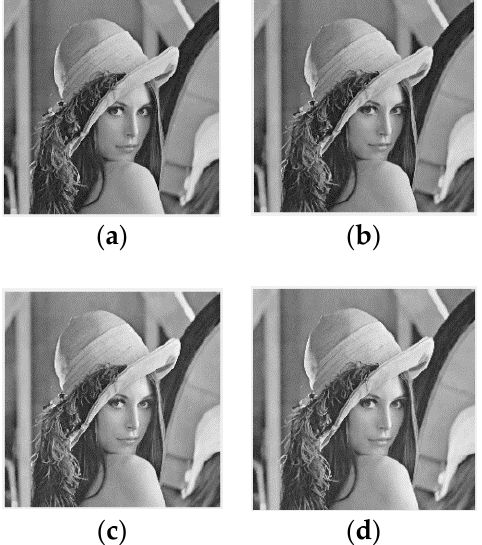
Figure 4. Data-embedded images obtained using different mechanisms. ( a ) Original input image, ( b ) M1: peak signal-to-noise ratio (PSNR) = 48 dB ( α = 10), ( c ) M2: PSNR = 26 dB ( α = 0.1), and ( d ) M3: PSNR = 25 dB ( α = 0.1).